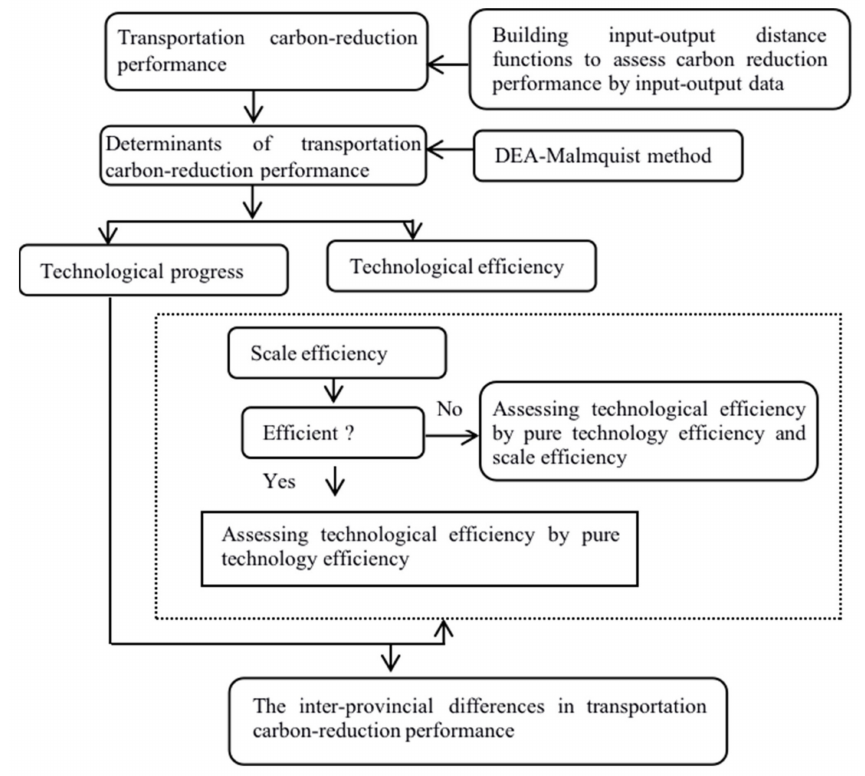
Figure 2. Methodological flowchart.